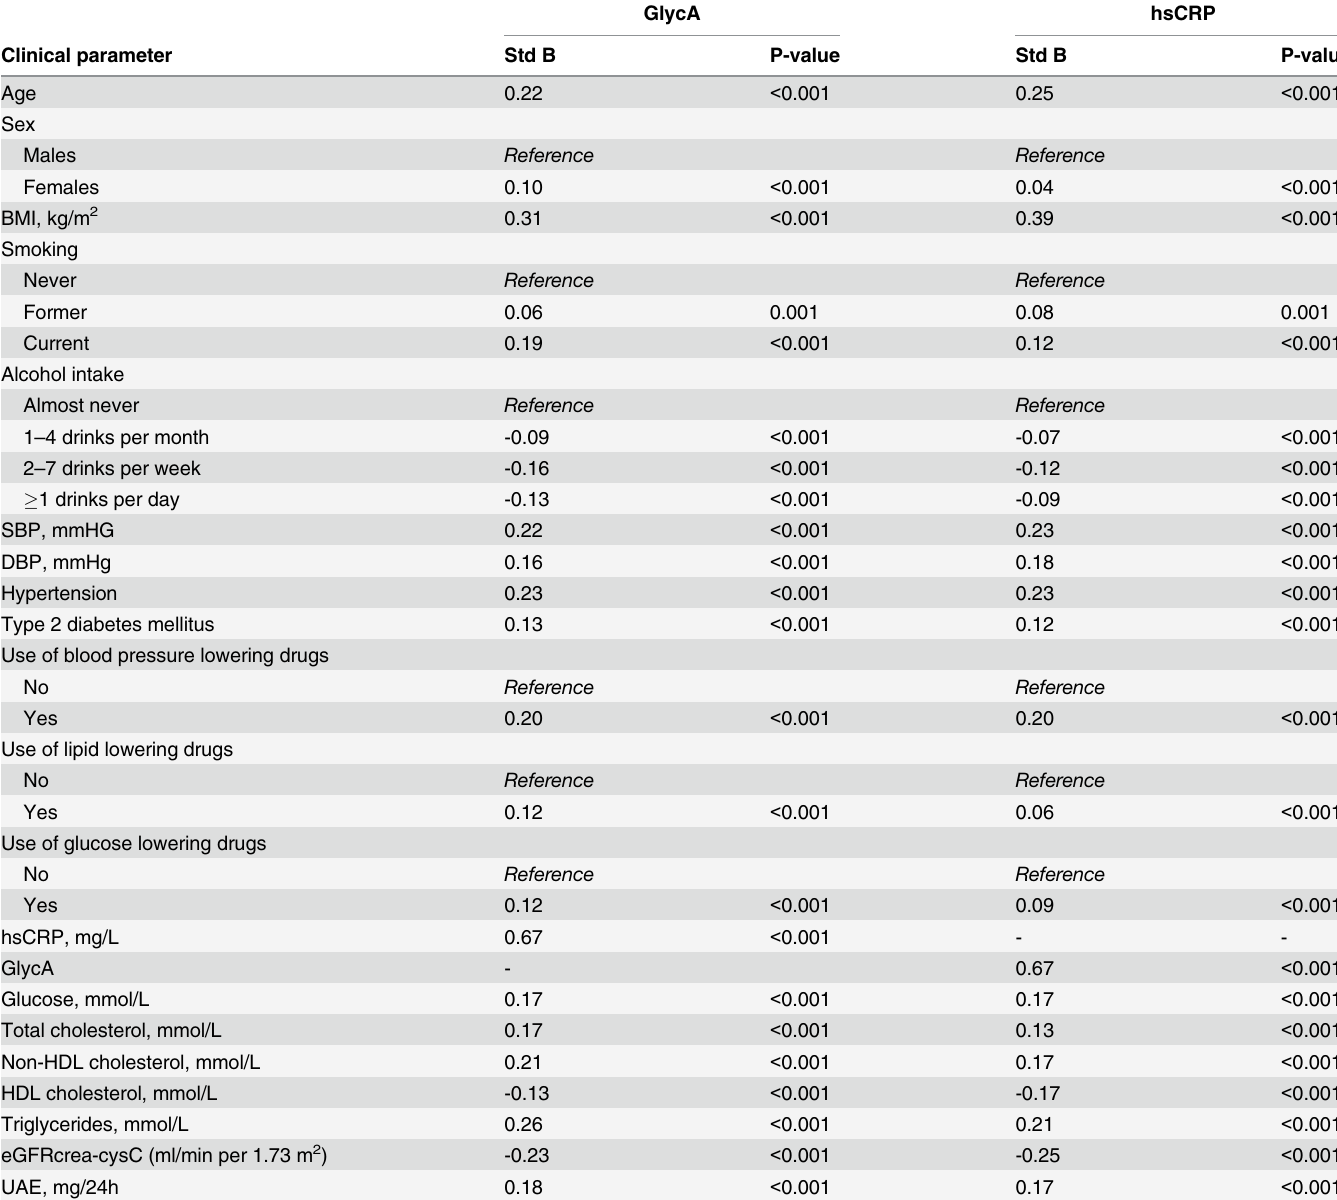
Table 2. Univariate associations of clinical parameters with GlycA and